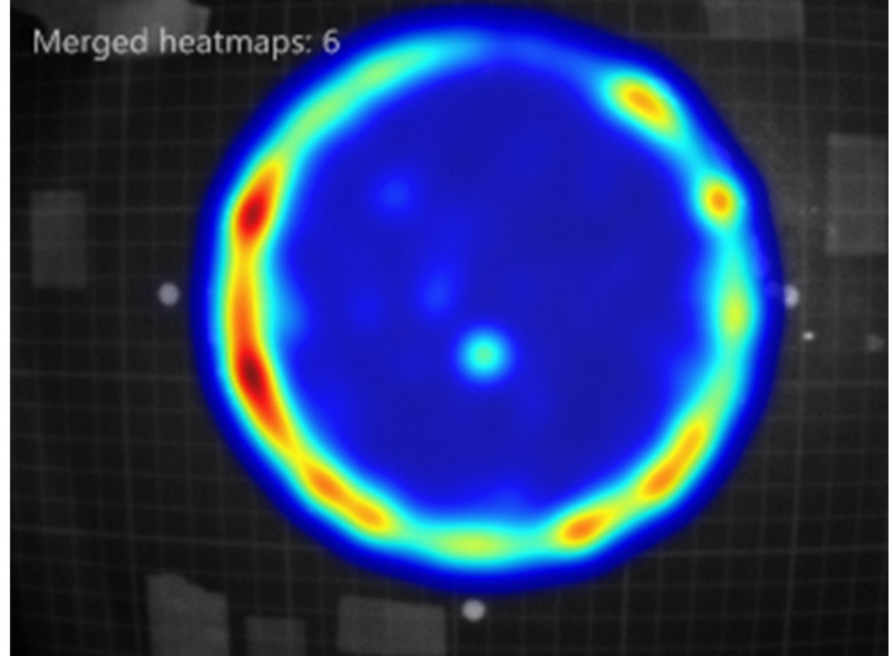
Figure 7. A representative heatmap showing where bed bugs within the four-disc repellency assay spent time, with cool (blue) colors indicating less time, and warm (red) colors indicating more time. The repellent treated filter paper disc was at the top position, while the three untreated filter paper discs were at the right, left, and bottom positions. This image was merged from six of the eight trials where methyl benzoate was tested after 24 h (the other two trials were performed on a second setup, and therefore not included in this file).